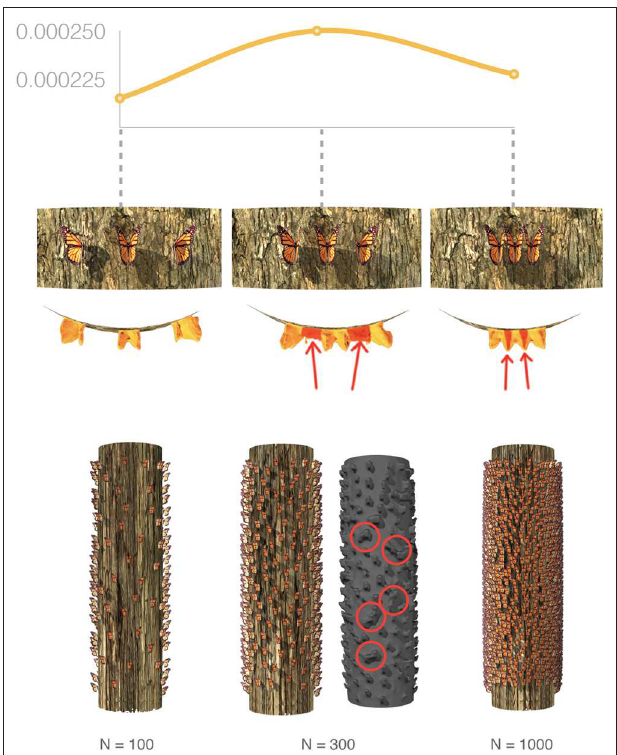
FIGURE 9 | Illustration of the non-linear deviation of estimates of individual butterfly volume as a function of cluster size and inter-individual spacing. The per butterfly volume is relatively low when around 100 butterflies are spaciously arranged and the photogrammetric and laser-scanning processes correctly detect each individual. At the other end of the spectrum, when 1,000 butterflies are arranged on the tree section, the survey processes correctly records the mass of tightly clustered individuals. However, the per butterfly volume is higher at intermediate values when gaps between intermittently spaced butterflies are not detected correctly and phantom volume is generated, necessitating the introduction of a correction factor (see text and Figure 11 ).